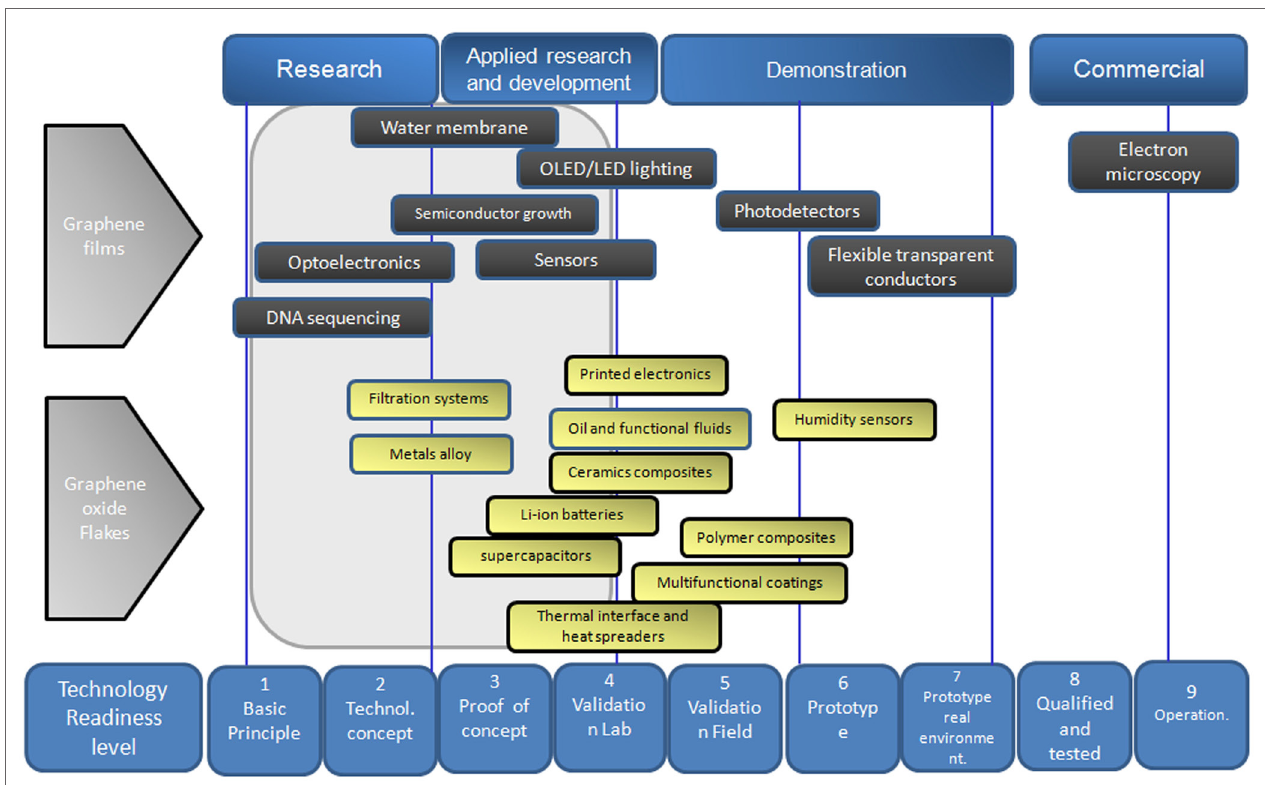
FiGURe 11 | Potential smart applications of graphene material as a function to the technology readiness level